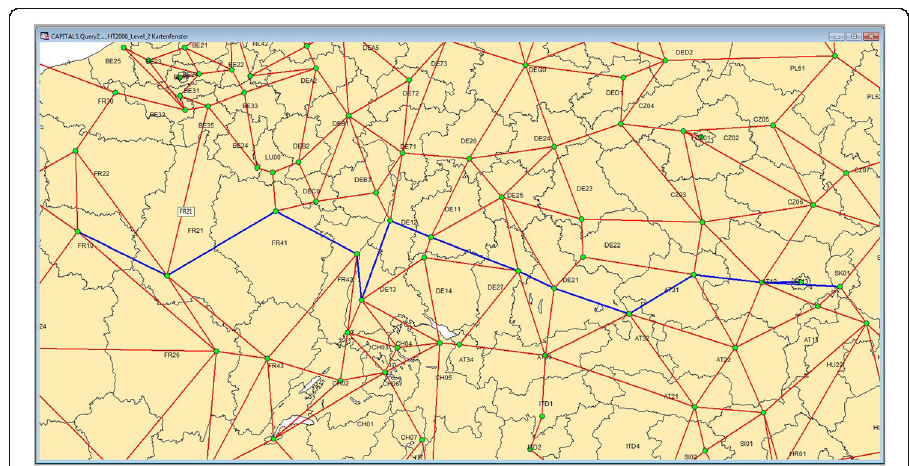
Fig. 11 Map showing the hypernet rail links of the Magistrale corridor (blue), other hypernet rail links (red) and NUTS-2 zone centroids